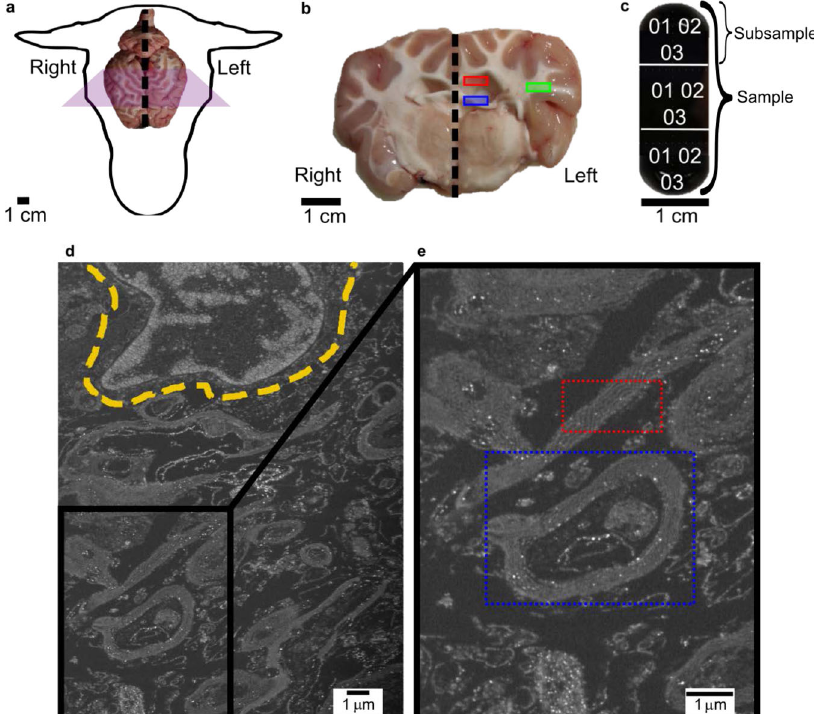
Fig. 2 Sampling from ovine cerebrum and acquired 2D FIB-SEM images. a Each brain was excised and immediately sampled. The samples have always been taken from a speci fi c part of the brain: the left hemisphere. b The samples come from different regions of the brain, samples from the Corpus Callosum (red box) being a Commissural Pathway, have fi bres that connect the two different hemispheres. Projection Pathways like the Corona Radiata in the green box, connect the cortex to subcortical structures. Finally, the long association pathway, the Fornix in the blue box, also connects regions that belong to the same hemisphere. c After fi xation, dehydration and embedding, the tissue is stored into capsule-like samples that follow a three-way subdivision for the imaging process that consisted in imaging three random locations in each of the subsamples for the 2D analysis and one extra location for the 3D analysis. d The stained tissue imaged by SEM shows the major cellular components of WM. The accessory cells (neuroglia), like the one in the yellow-dashed line, appear as blobs with rami fi ed protrusions reaching out in the interstitial spaces. e The axons appear as white ringed structures (dashed blue box) as they are wrapped in their myelin sheaths and at a further magni fi cation it can be seen where the membranes of specialized accessory cells, the oligodendrocytes, come appose and appear as white and dark bands packed together in a layer (dashed red